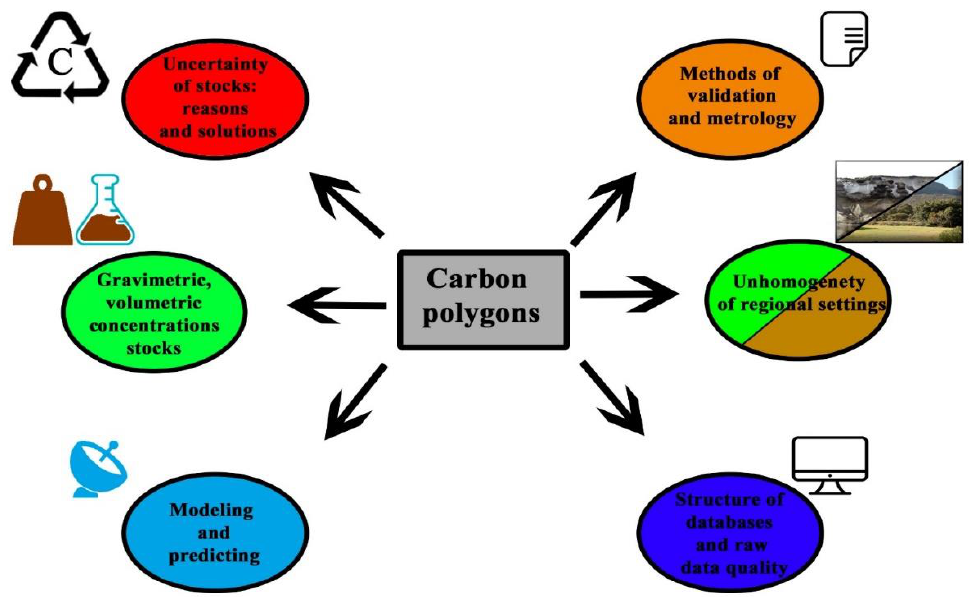
Figure 1. Responsibility tasks of carbon polygons.